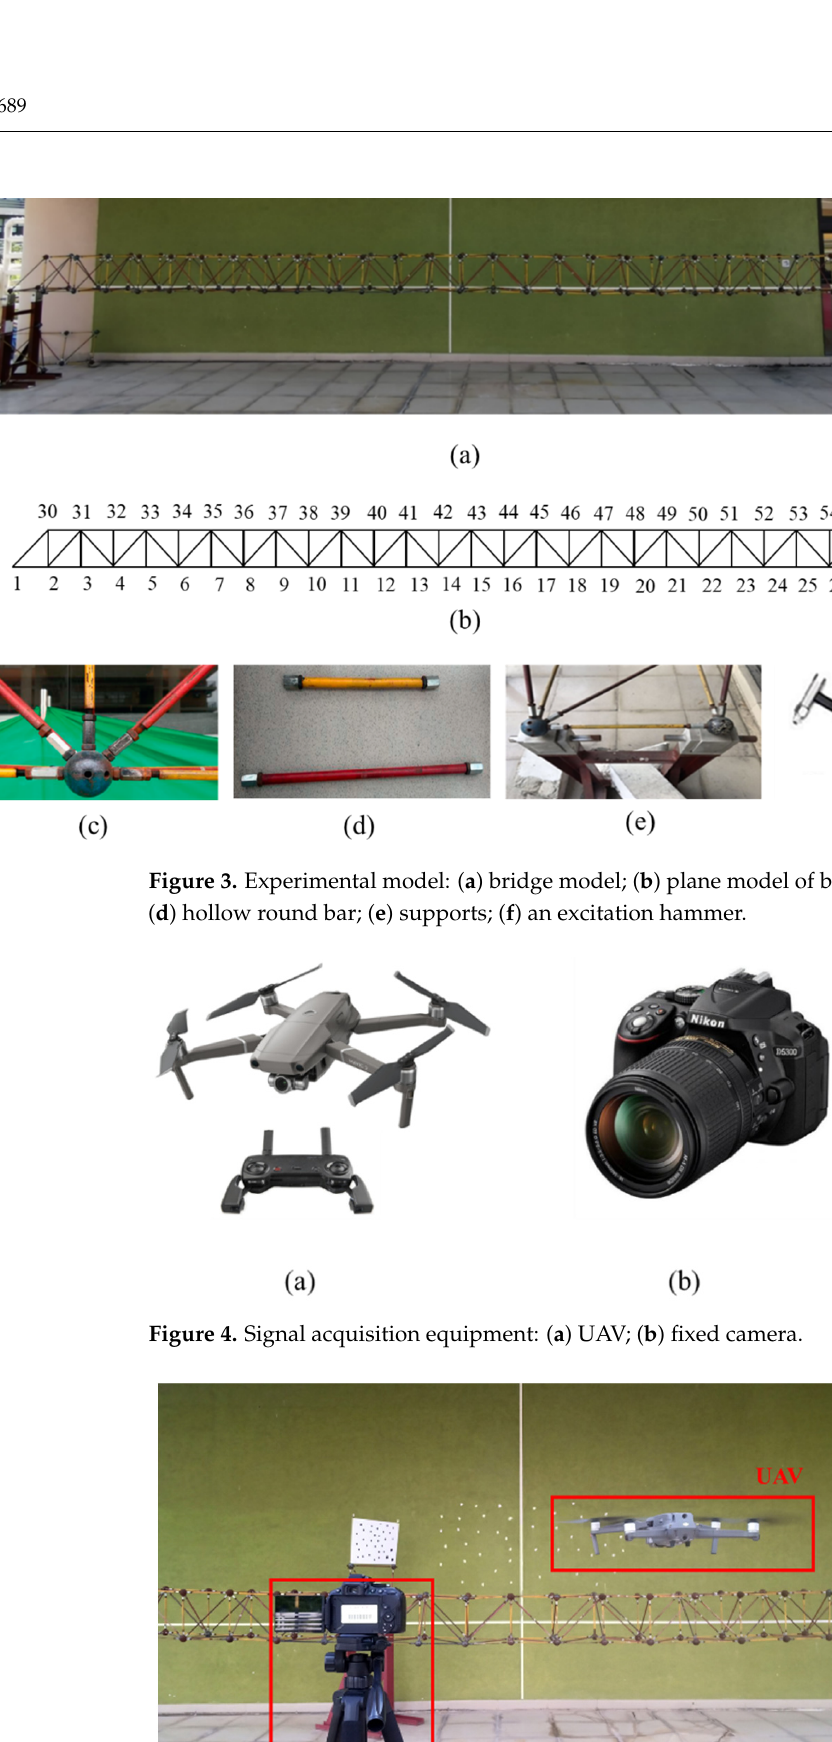
Figure 5. Experimental layout.